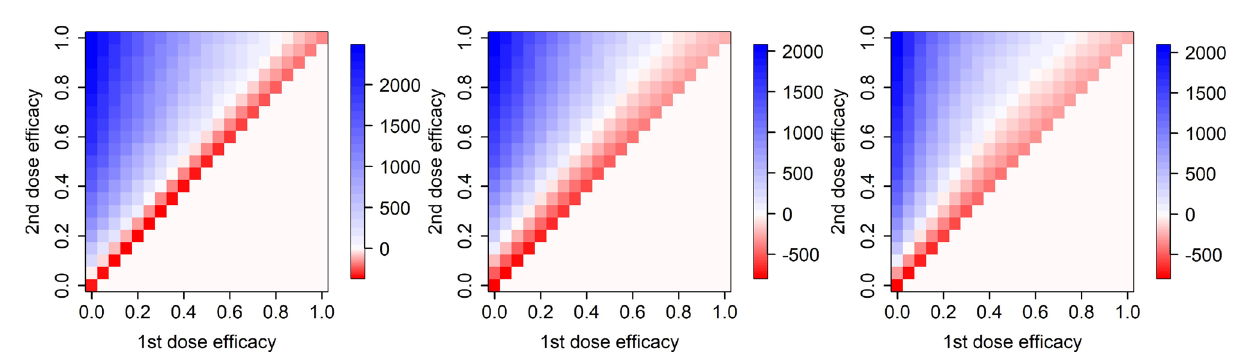
Figure 9. Efficacy of delaying the second vaccine dose by 3 weeks from 21 to 42 days, assuming waning vaccine efficacy against infection and symptoms appearance with v w = 0.2 , v w = 0.3 (middle), and with all considered modes of action together and symptoms appearance with v 1 2 w = 0.2 , v w = 0.3 ). Only model H is used (right, v 1 2